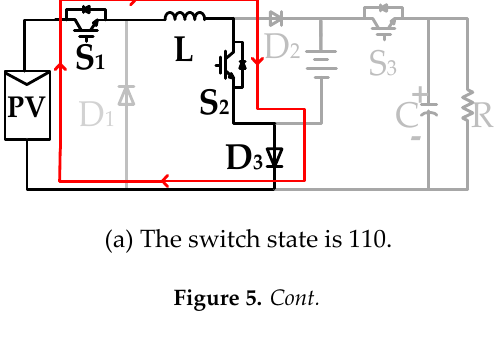
(a) The switch state is 110. Figure 5.